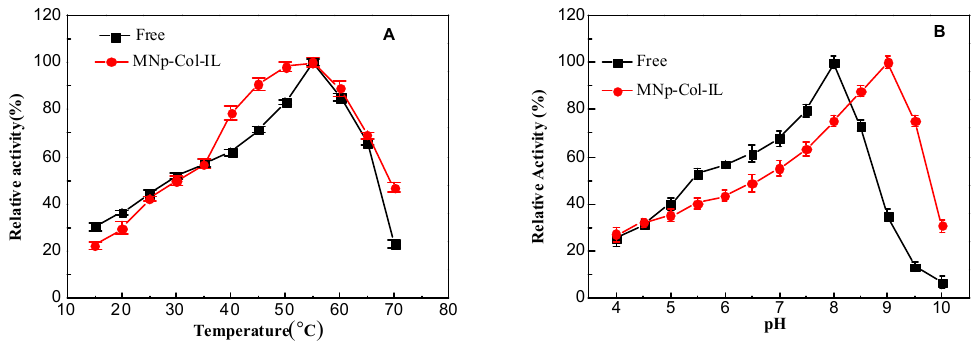
Figure 5. Effect of Temperature and pH on the relative activity. ( A ) temperature, and ( B ) pH.